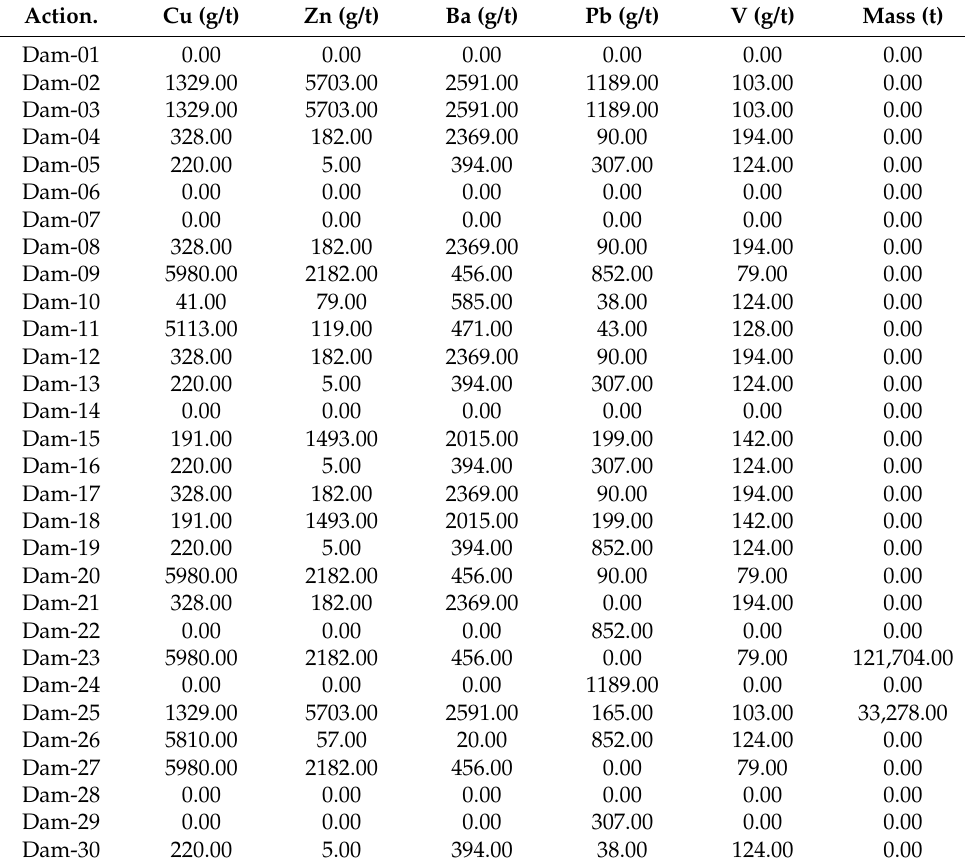
Table 3. Active Scenario 2 evaluations (sample of first 30 actions).